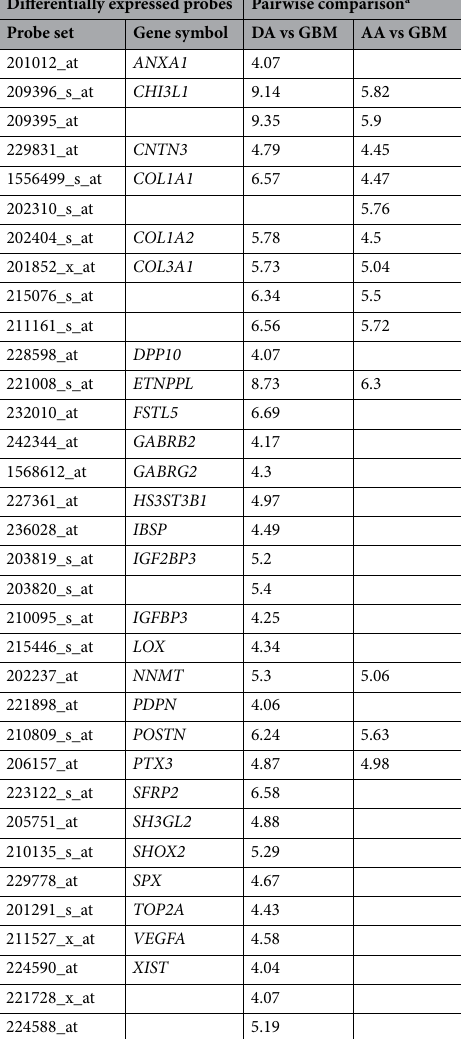
Table 1. Gene probes that showed significant discriminatory power -fold-change (FC) > 4- among distinct histopathological subtypes of gliomas as identified in pairwise comparisons (n = 34 probes corresponding to 27 different genes). Results expressed as fold-change (FC) values for pairwise comparisons. DA diffuse astrocytoma, AA anaplastic astrocytoma, GBM glioblastoma